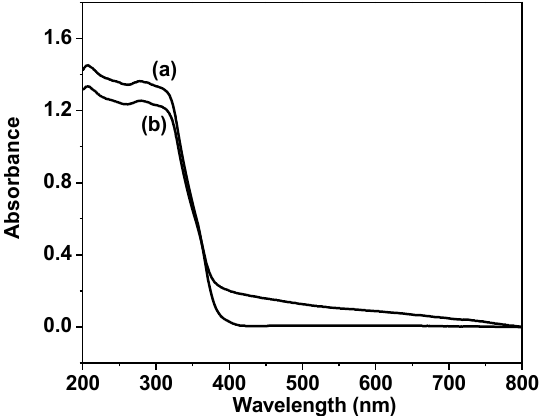
Figure 9. Diffuse reflectance spectra of pure SrTiO 3 (a) and 1.5 wt.% CuO-SrTiO 3